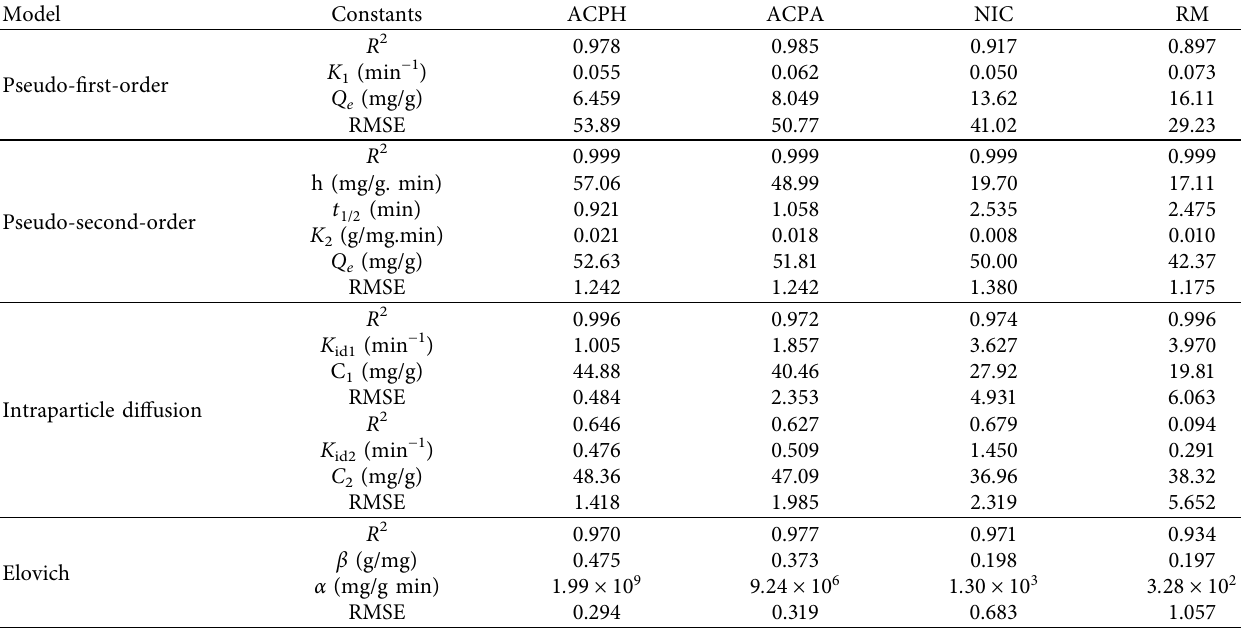
Table 6: Results of adsorption parameters for the different kinetic